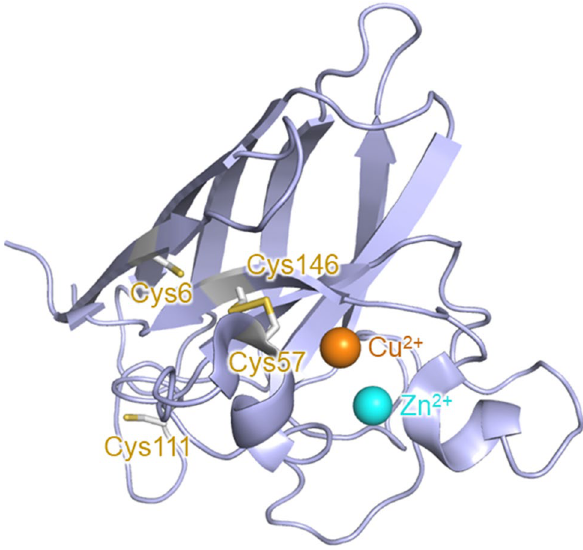
Figure 1. Crystallographic structure of the monomer unit of wild-type SOD1 (PDB code: 1PU0 26 ). The Cu and Zn ions are shown as orange and light blue spheres, respectively. The cysteine residues are shown as sticks. Cys6 and Cys111 are in the free thiol state, while Cys57 and Cys146 form an intramolecular disulfide